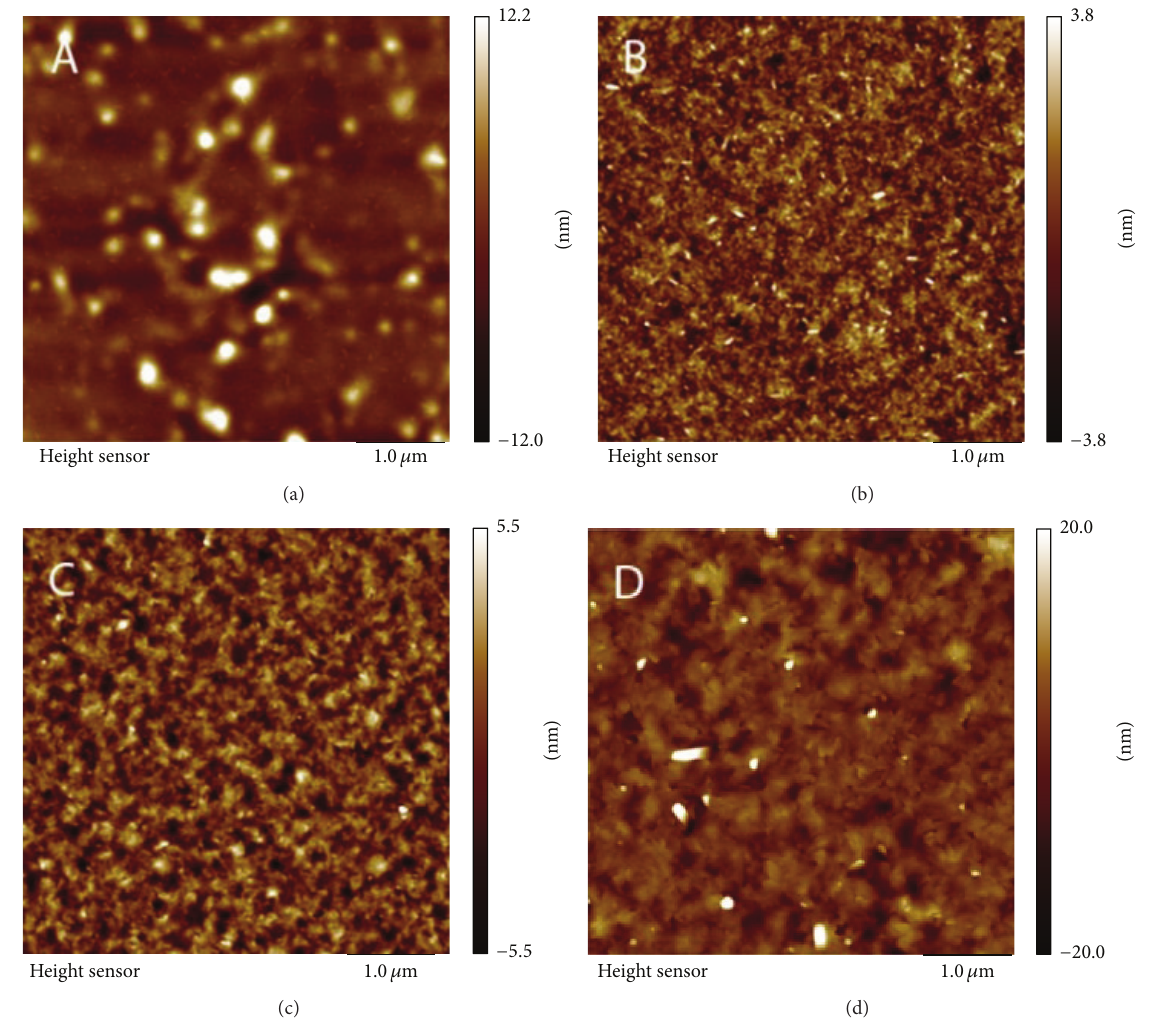
Figure 4: AFM images of the ethyl-hexyl alkylated (compound (A)) DPP(TBFu) 2 :PC 60 BM blend: as-cast (A) and annealed at 110 ∘ C (B), 140 ∘ C (C), and 160 ∘ C (D).